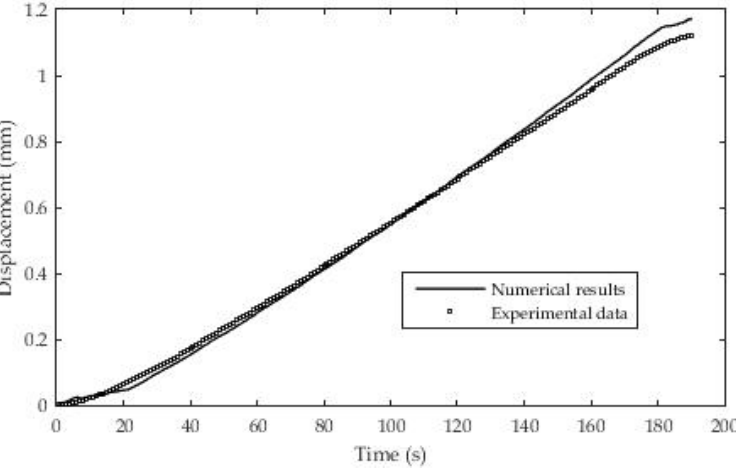
Figure 21. Experimental and numerical data for displacement.